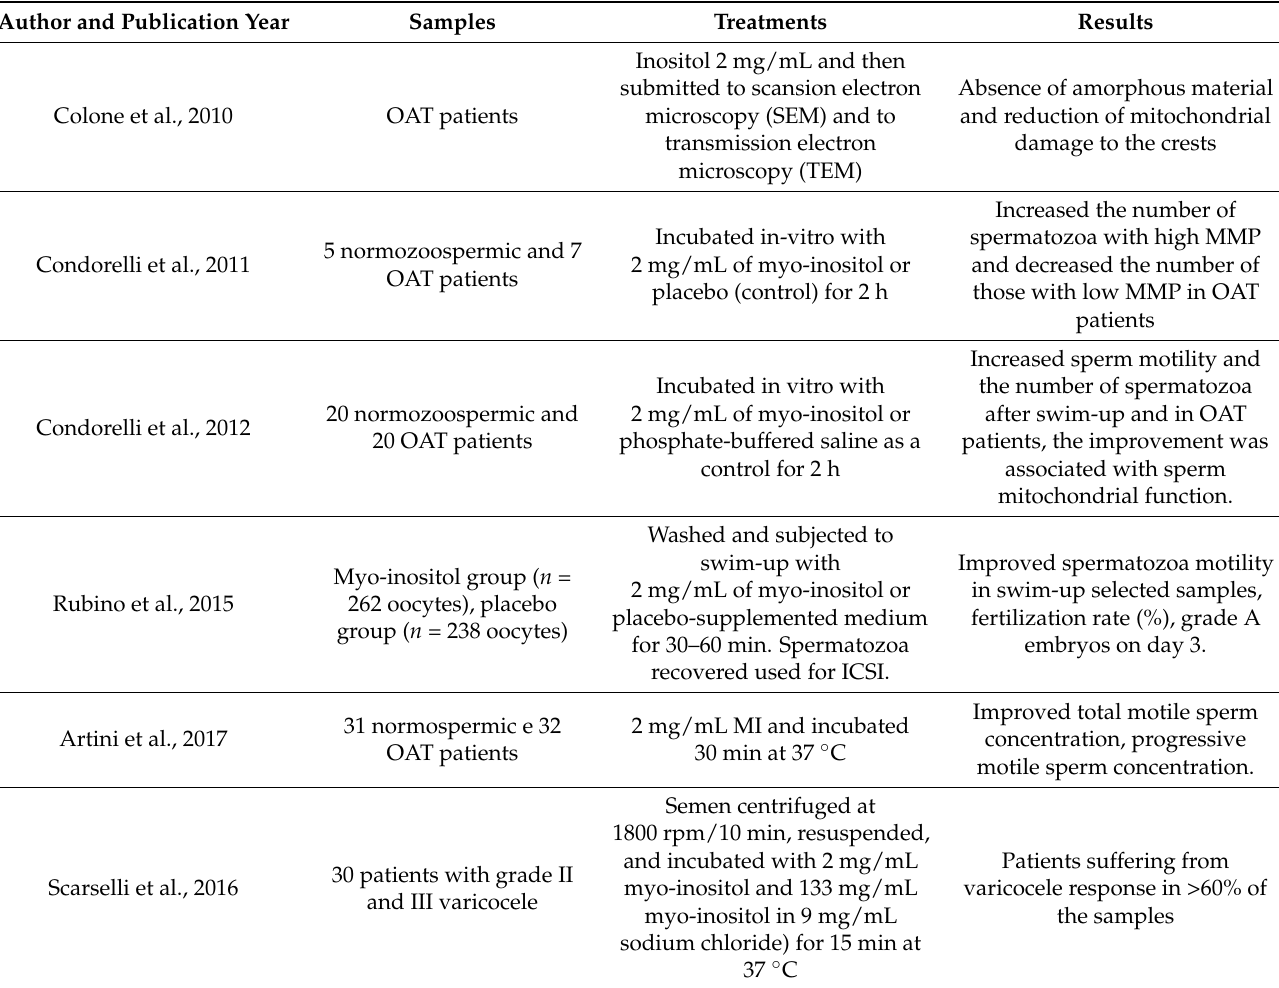
Table 1. Myo-inositol: in vitro